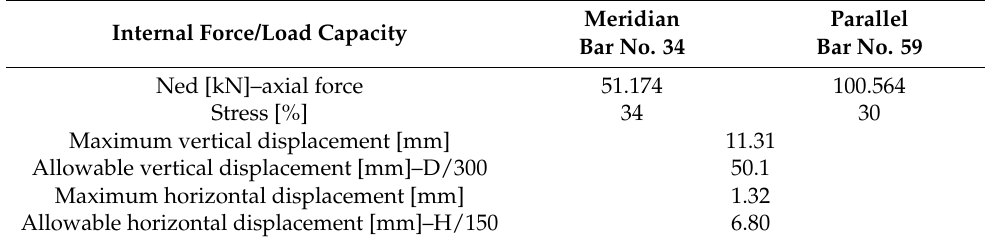
nonlinear cally nonlinear analysis.